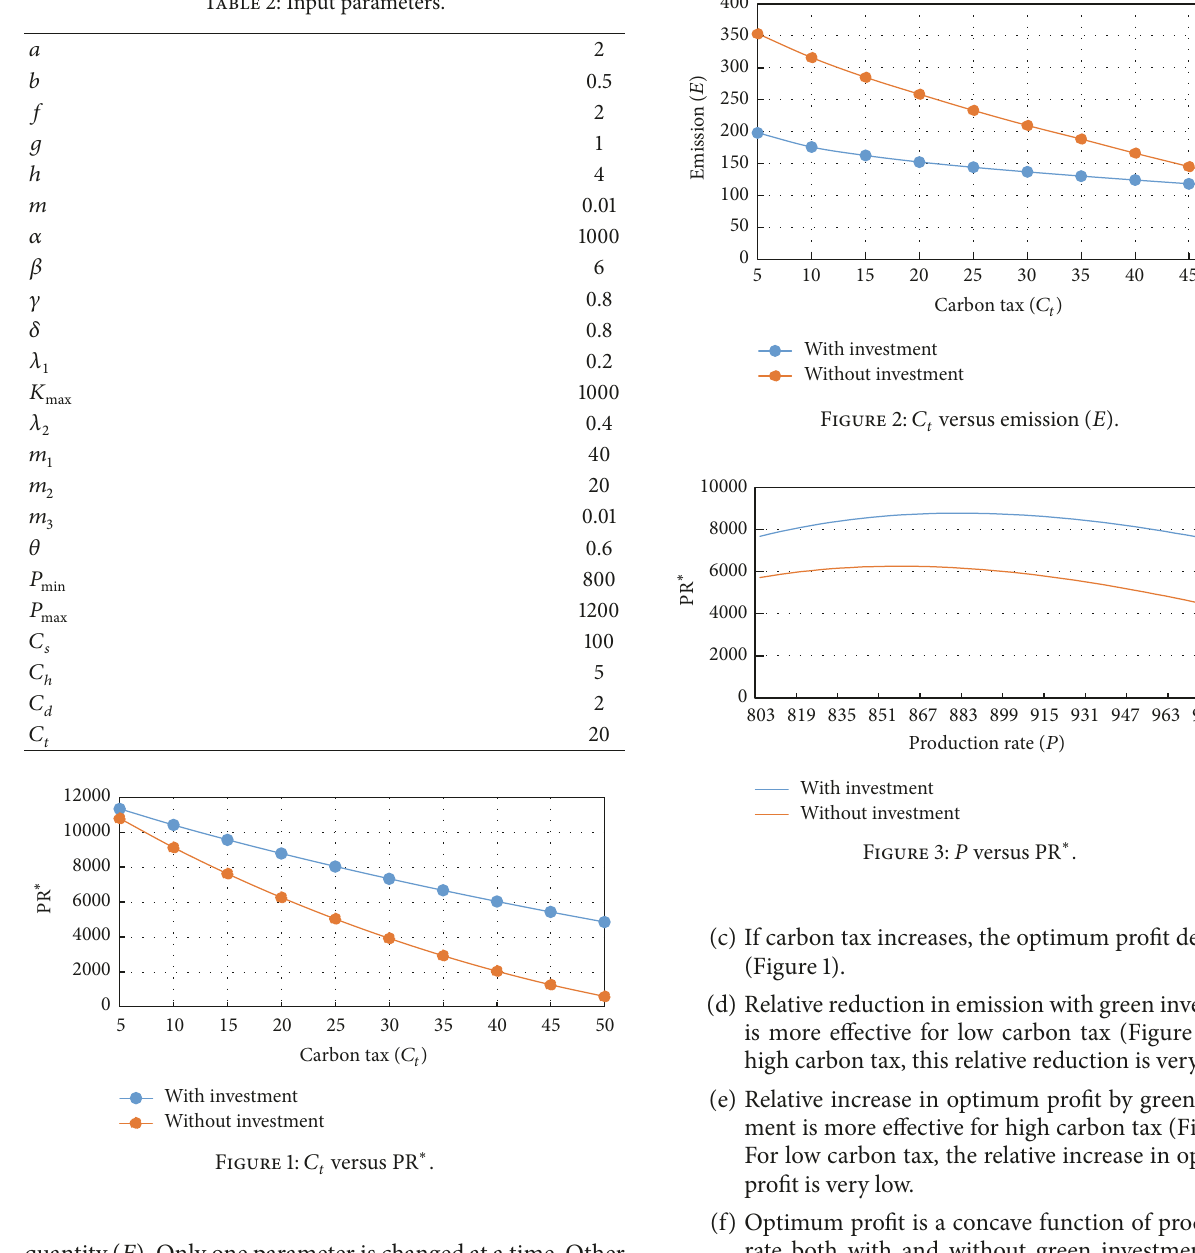
Table 2: Input parameters.